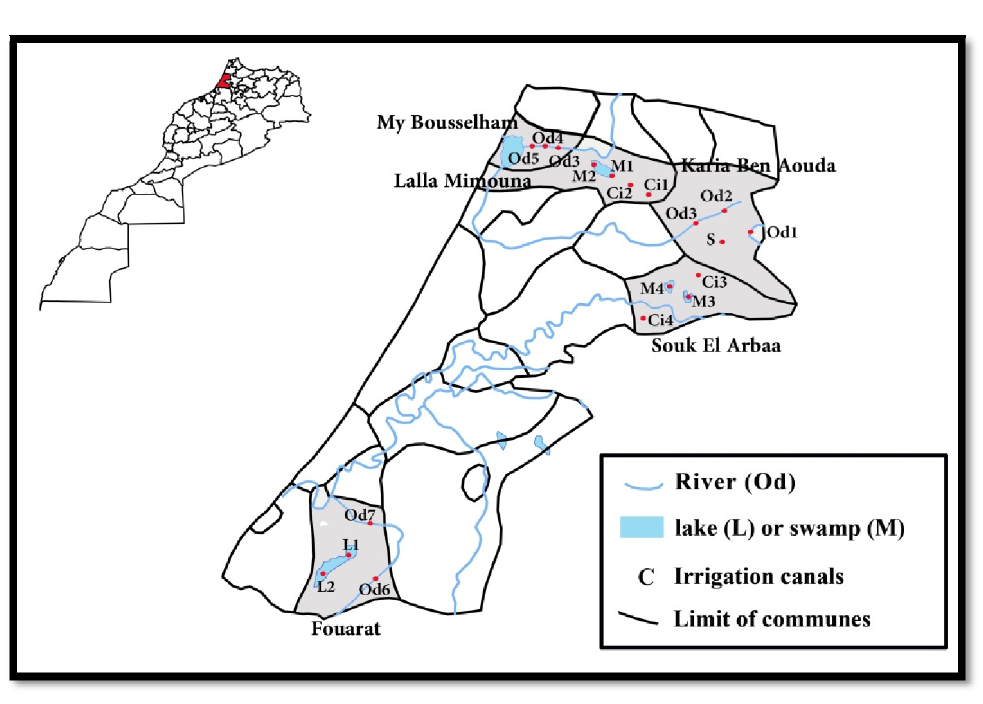
Figure 1. Geographic distribution of sampling areas for freshwater mollusks (red